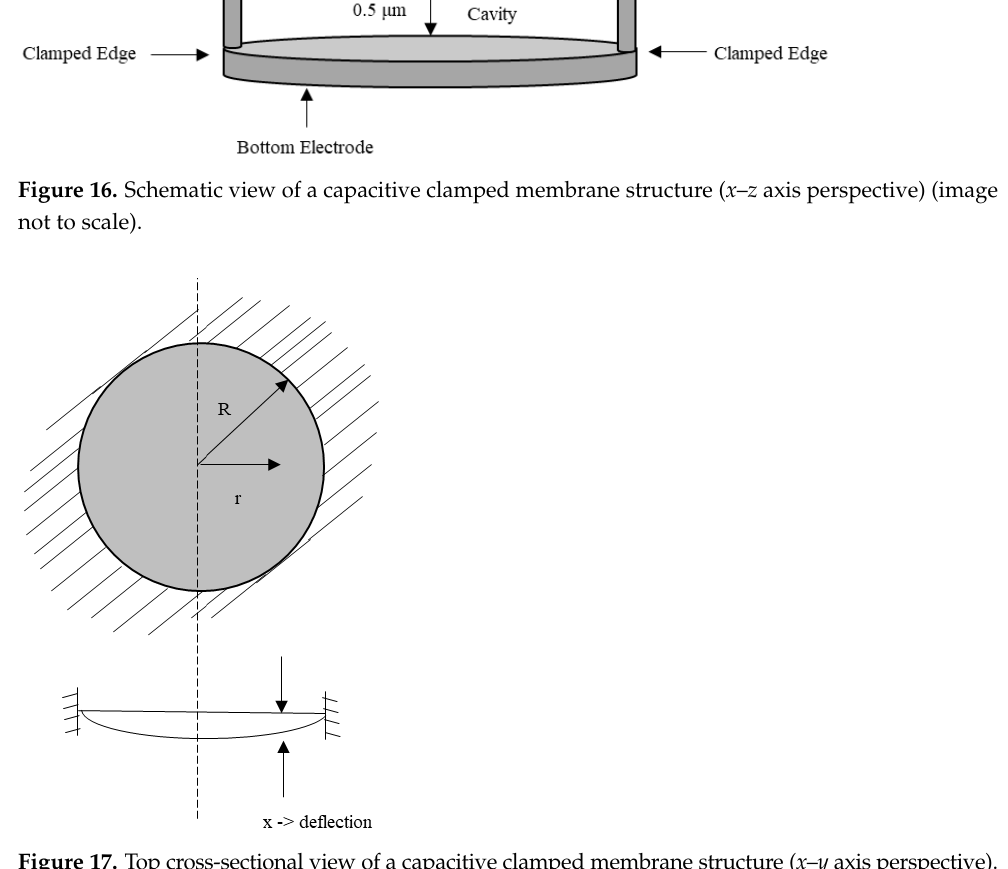
Figure 17. Top cross-sectional view of a capacitive clamped membrane structure ( x – y axis perspec- tive).